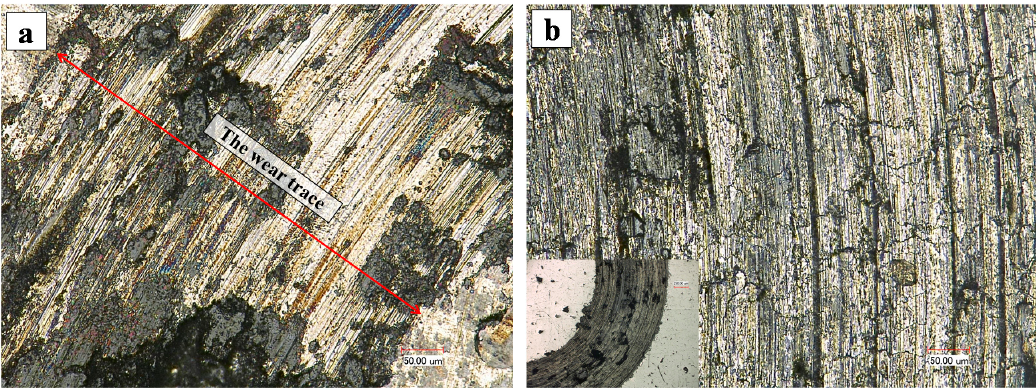
Figure 11. Optical micrographs of the wear trace: ( a ) coating; and ( b ) substrate.